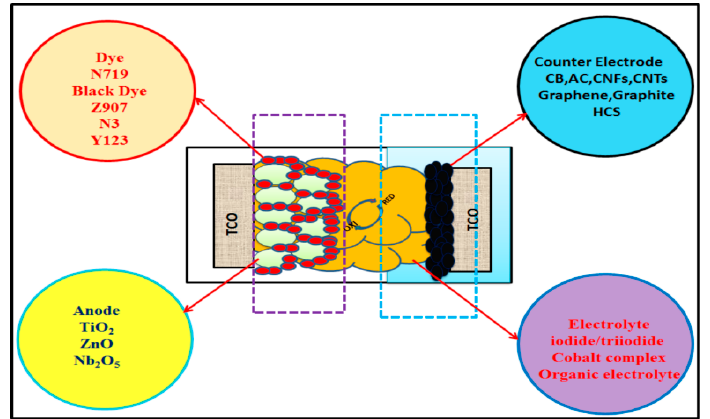
Figure 1. Schematic representation of the components used in dye-sensitized solar cells (DSSCs). TiO 2 = titanium dioxide, ZnO = zinc oxide, Nb 2 O 5 = niobium oxide, CB = carbon black, AC = activated carbon, and CNTs = carbon nanotubes.